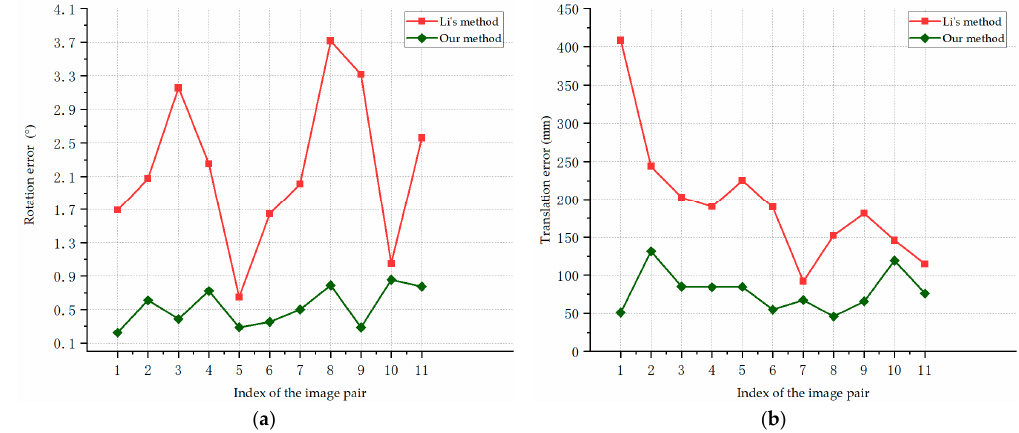
Figure 14. Pose estimation errors on the synthetic images of F35 model in Scene 2: ( a ) rotation errors; ( b ) translation errors.